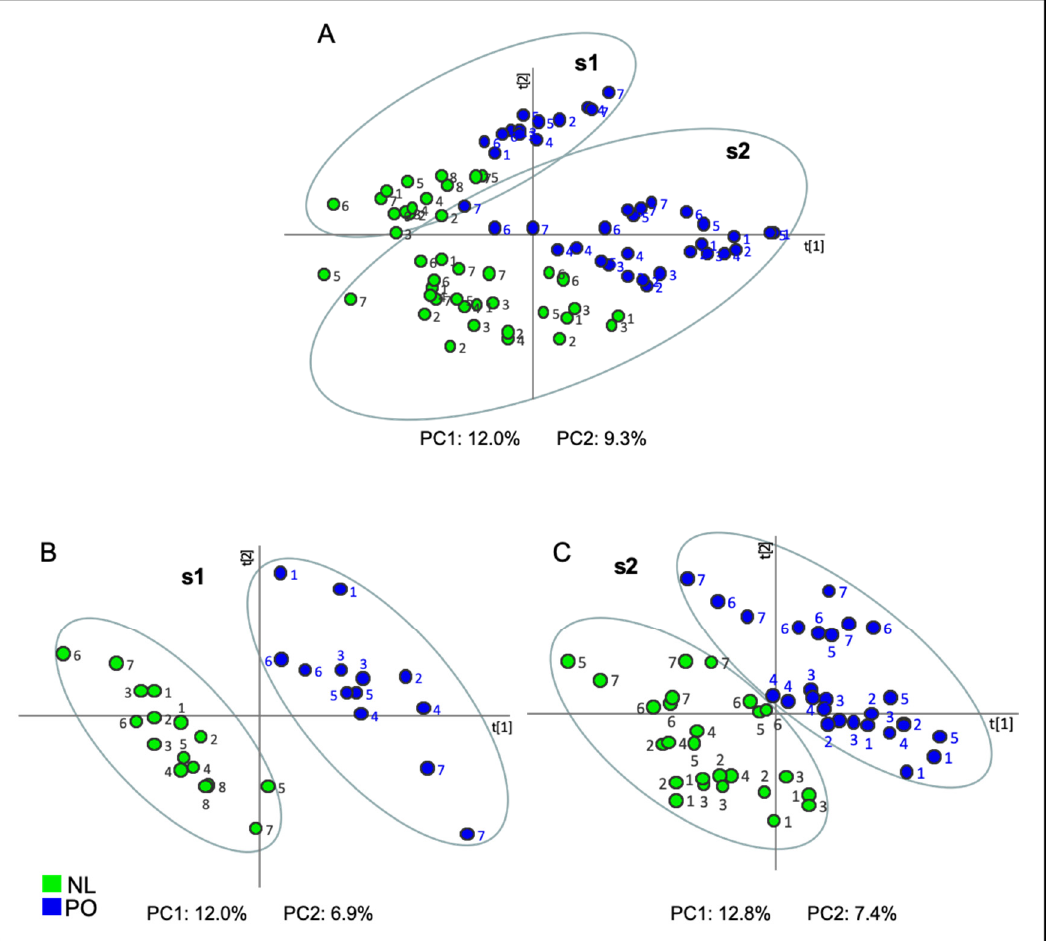
Figure 2. Score plot of Projection to Latent Structures-Discriminant Analysis (PLS-DA) based on the whole array of the mass spectra within a m/z range from 35 to 220 obtained from samples of Clemenules (NL: green) and Clemenpons (PO: blue) collected during ( A ) both s1 and s2; ( B ) during s1 in a unique location; ( C ) during s2 in two locations. Numbers 1 to 7 account for harvest day, from earlier (1) to later dates (7). Only for NL variety, the later date in s1 was date (8). PC1: first principal component; PC2: second principal component.